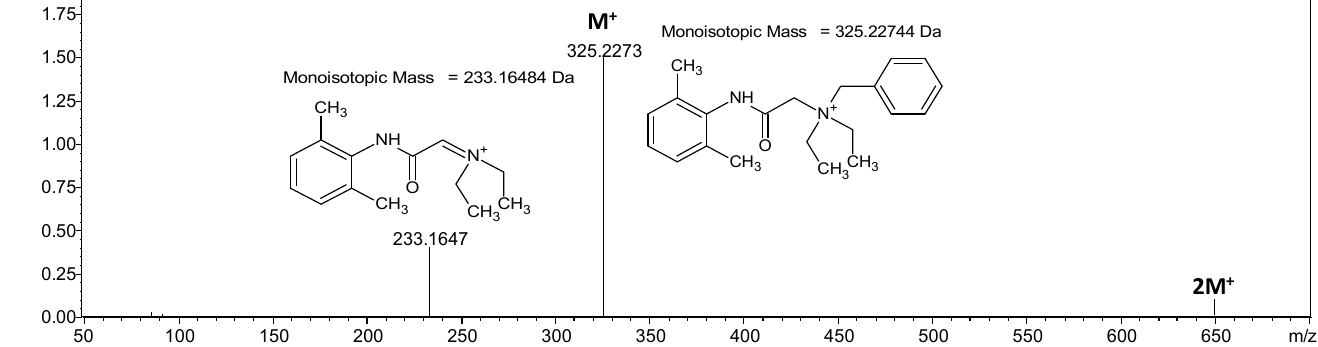
Figure 2. ESI-MS/MS spectrum of denatonium cation dimer in the positive ion mode. m / z range from 50 to 1000. Parent ion m / z 649.4475, collision energy 18–52 eV.